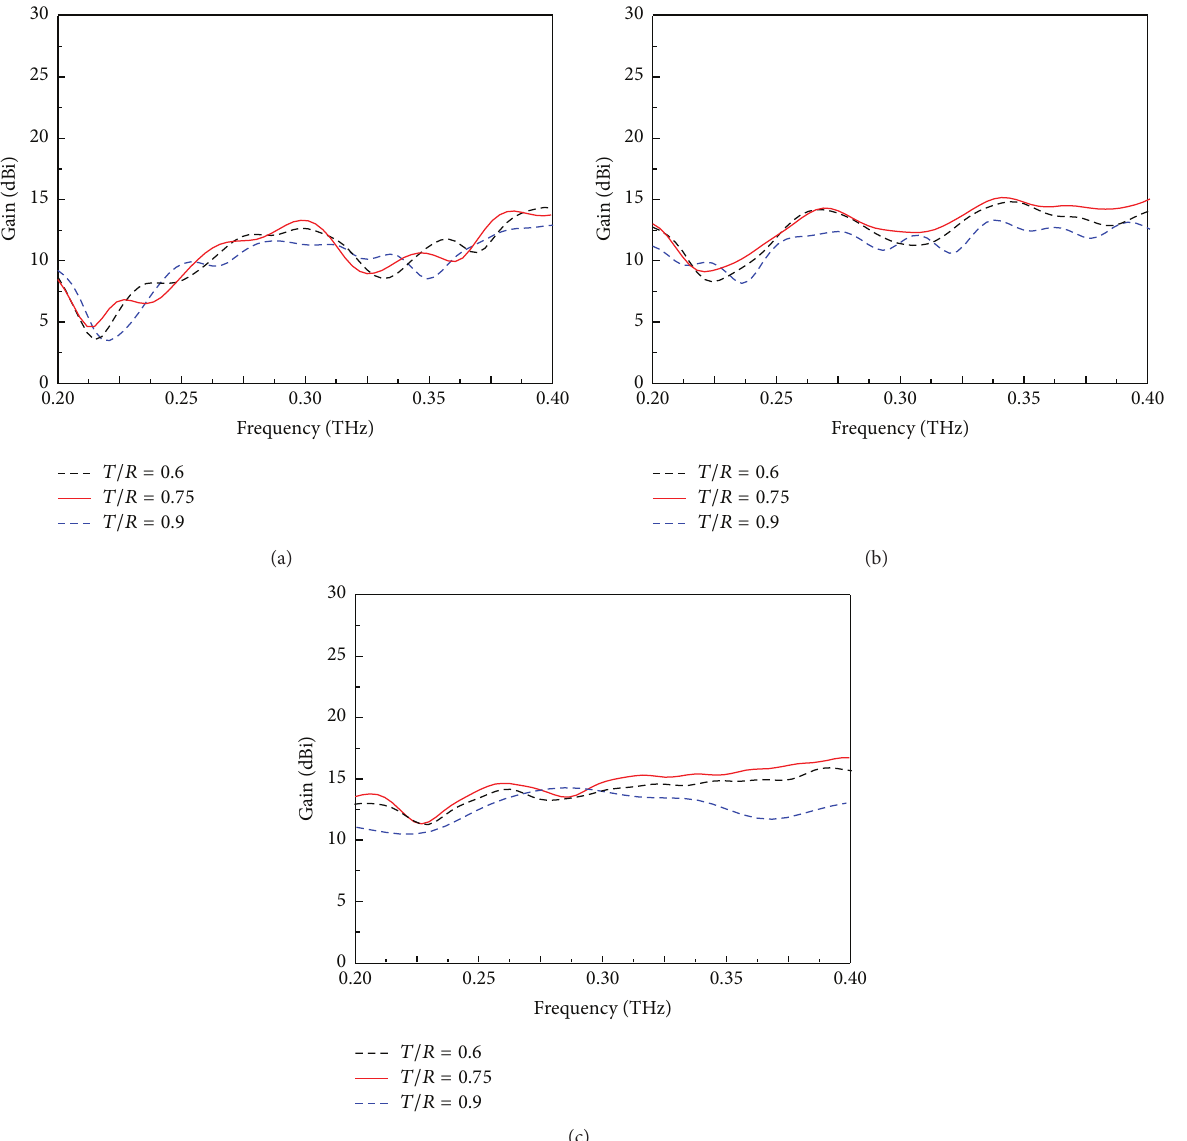
in Figure 8. The smaller lenses ( 𝑅 = 0.8 𝜆 𝑜 and 𝑅 = 1.2 𝜆 𝑜